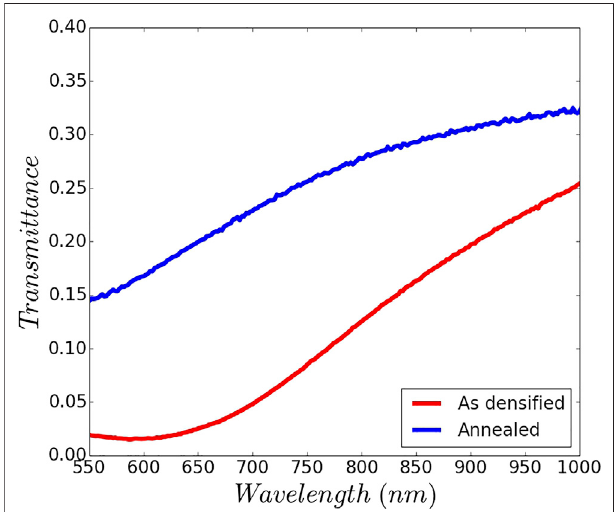
FIGURE 2 | As densi fi ed and 24 h annealed transmittance measured at a region in the nc-YSZ ceramic far away from the laser written planar waveguide.